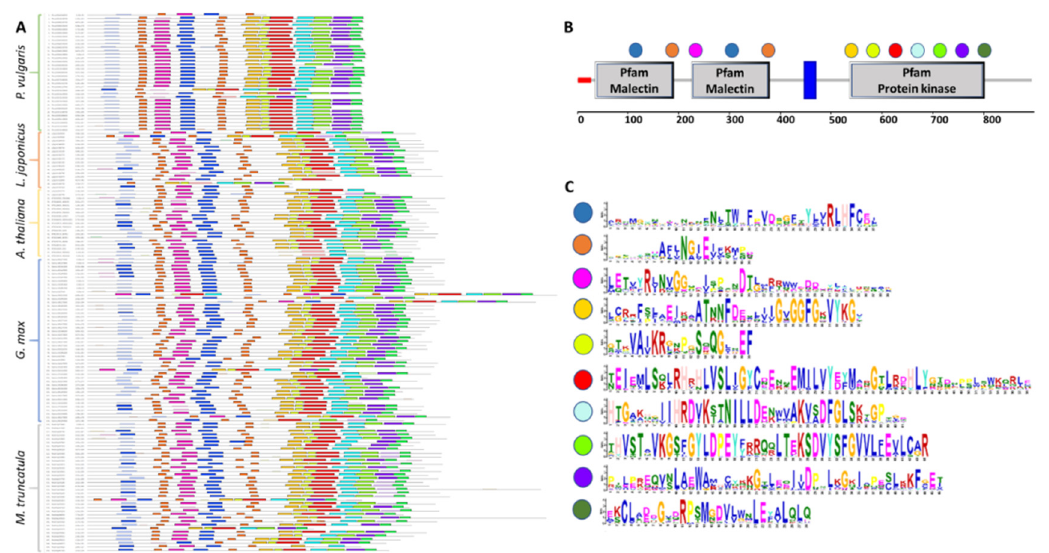
Figure 2. CrRLK1L protein sequence conservation and characteristic motifs in legumes and A. thaliana . MEME was used to identify motifs in the 150 CrRLK1Ls from four legumes and A. thaliana . ( A ) Diagram of the motifs in the CrRLK1L protein sequences from P. vulgaris , L. japonicus , G. max , M. truncatula , and A. thaliana . Significant overrepresented motifs are graphically depicted by bars corresponding to their predicted position. ( B ) Localization of overrepresented motifs identified using MEME in the CrRLK1L protein domains. ( C ) Logo of the overrepresented motifs identified with MEME; the color code corresponds with that used in ( A ) and ( B ).